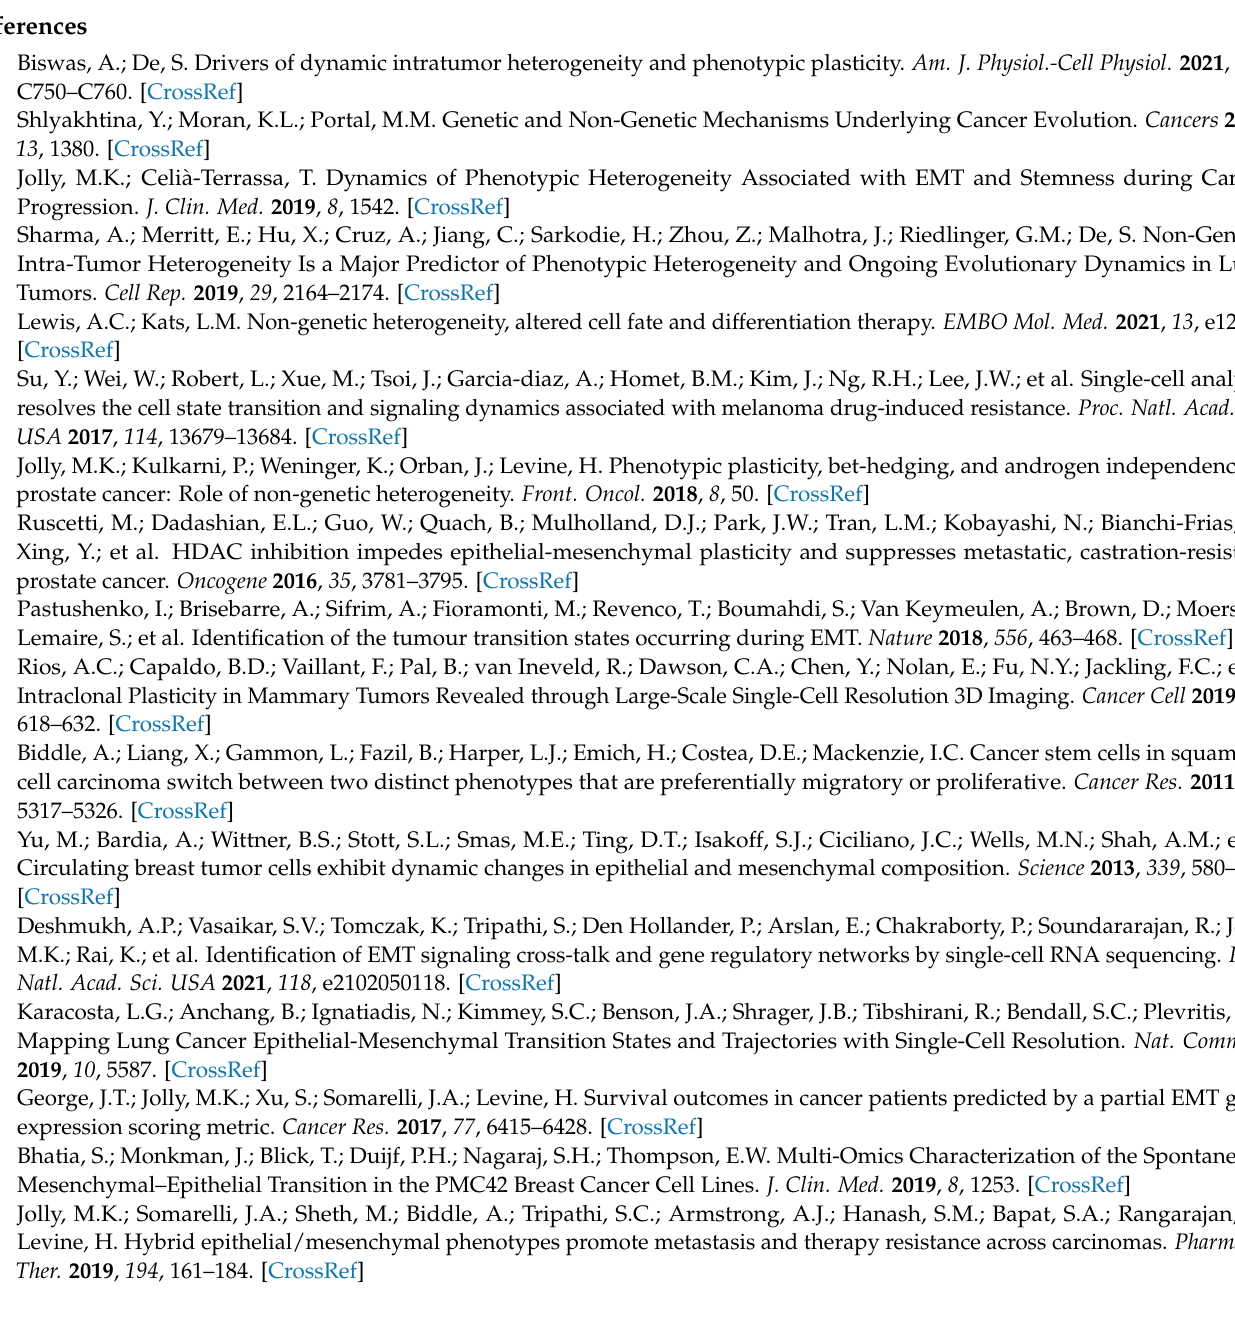
Figure S6: Statistical analysis of differences in minimum cell cycles required for asymmetric division for a cell of given phenotype and SNAIL level on keeping η 1 fixed (0.2) and varying η 2